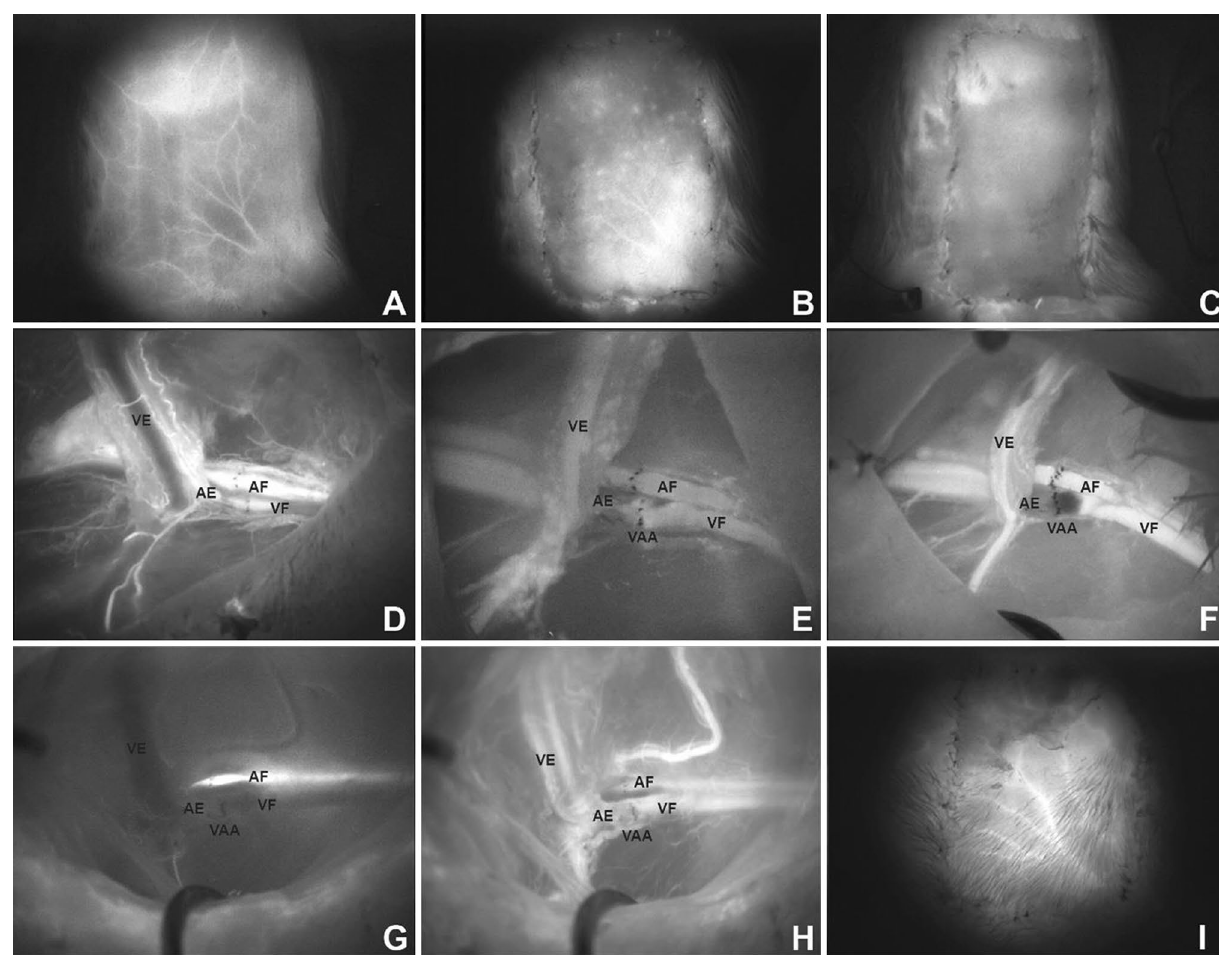
Figure 4. Results of ICG videoangiography. Decreased perfusion after flap raising (B, venous phase at 60 s) compared with flap perfusion before the raising [( A ) arterial phase at 15 s)] in groups II and III. Note the perfusion pattern after flap raising ( B ); no ICG fluorescence in the flap immediately after flap raising in group I [( C ), venous phase at 75 s]; venous flow-through the anastomosis in group I was not seen [( F ) venous phase at 65 s]; venous perfusion through the anastomosis in groups II and III 7 days after flap raising [( H ) venous phase at 40 s] clearly increased compared with that directly after raising [( E ) venous phase at 57 s]; no retrograde perfusion at the end of the experiment [( G ) arterial phase at 15 s] compared with retrograde arterialized femoral vein through mammarian artery directly after microanastomosis [( D ) arterial phase at 17 s]; increased ICG fluorescence at the end of the experiment [( I ), venous phase at 45 s] compared with the perfusion pattern directly after flap raising [( B ) venous phase at 60 s] in groups II and III. AF—arteria femoralis; AE—arteria epigastrica; VF—vena femoralis; VE—vena epigastrica; VAA—veno-arterial